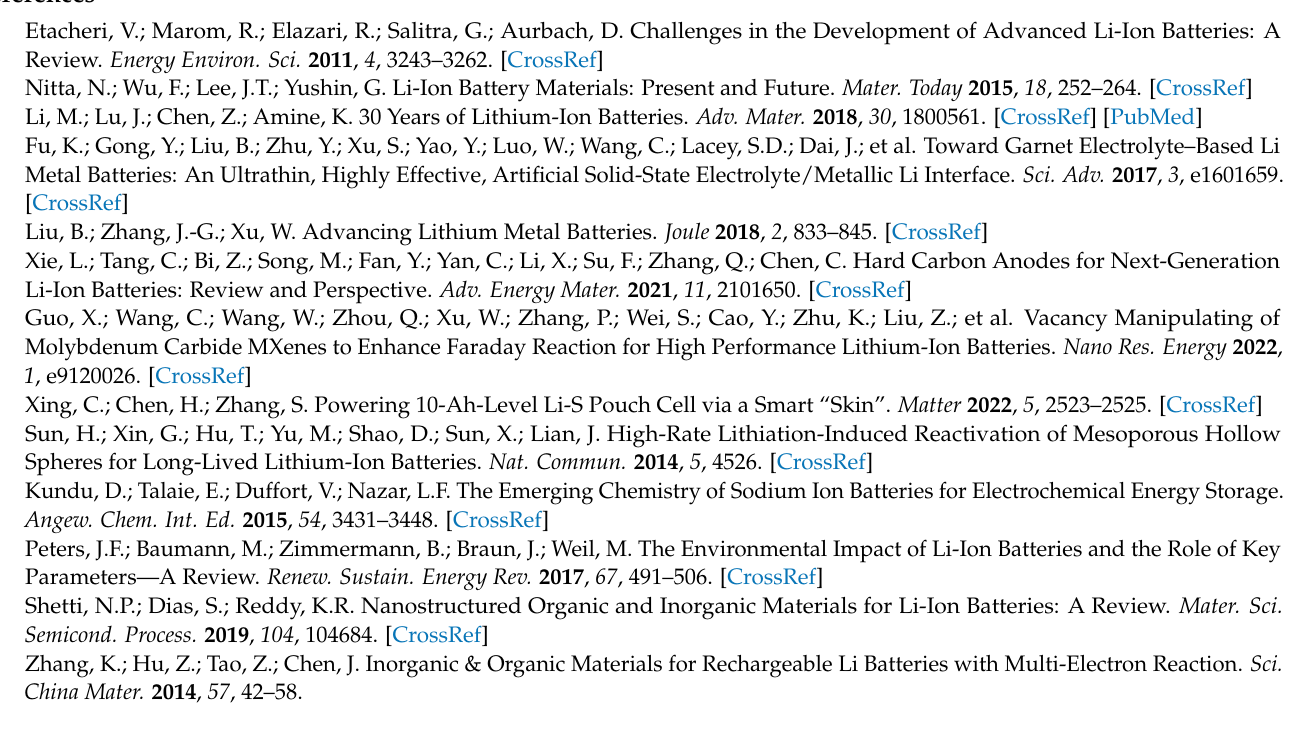
Figure S2. The solubility comparison of TP and TP-Ni; Figure S3. XRD profiles of TP and TP-Ni; Figure S4. XPS spectra before and after coordination of (a) Ni 2p, (b) C 1s, (c) O 1s; Figure S5. The Raman spectra of TP and TP-Ni; Figure S6. (a) Nyquist plot of EIS spectra, (b) relationship between real part of impedance and ω − 0.5 in TP and TP-Ni cells; Figure S7. Galvanostatic charge and discharge curves of TP anode at a current density of 0.1 A g − 1 ; Figure S8. Rate performance of TP anode; Figure S9. Long cycling performance measured at a current density of 1.0 A g − 1 ; Figure S10. XPS spectra of Li 1s in TP-Ni electrodes during the first discharge/charge cycle; Figure S11. XPS spectra of Ni 2p in TP-Ni electrodes during the first discharge/charge cycle; Figure S12. The summary of impedances at different discharge/charge states in the first cycle; Figure S13. (a) Nyquist of TP-Ni anodes after different cycles. (b) The summary of impedances after different cycles; Table S1. The content of different elements in the prepared TP-Ni material according to EDS; Table S2. The Rct and DLi+ of TP and TP-Ni electrodes from